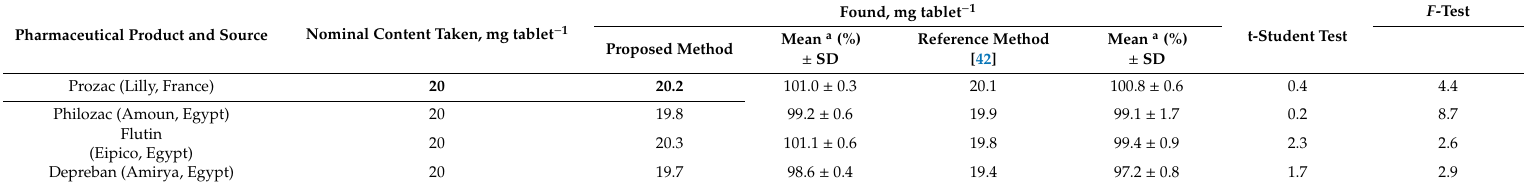
Table 3. FLX determination in pharmaceutical preparations using the proposed membrane sensor and reference